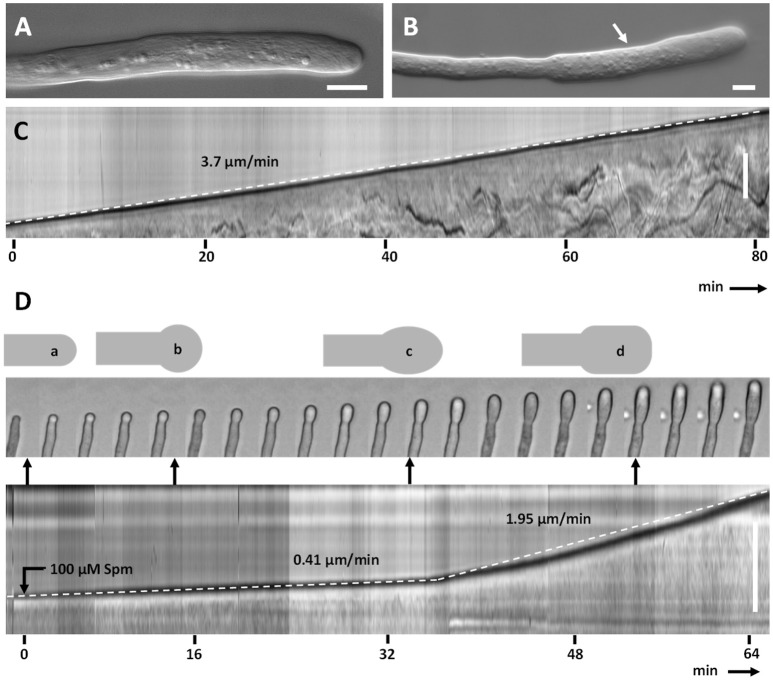
Kymograph analysis of pear pollen tubes after Spm treatment. (A) DIC view of a control pollen tube. (B) A typical enlarged pollen tube after Spm treatment. Bars: 20 μm. (C) Control pollen tube analyzed by kymograph. The dotted line indicates the linearity of growth. The X-axis is the time in minutes, while the Y-axis is the distance covered by the tube tip (scale bar for Y-axis is 100 μm). (D) (top part) Video frames showing the effects induced by Spm on a pollen tube. Cartoons indicate the main morphological stages that characterize pollen tubes after Spm treatment; (a) no Spm; (b) balloon shape; (c) snake shape; (d) shovel shape (bottom part). Kymograph analysis of a Spm-treated pollen tube. Spm was added at time zero. Scale bar for Y-axis is 500 μm. Small black arrows connecting the kymograph with video frames indicate approximately the time characterized by the four pollen tube shapes. Data are representative of six independent experiments.